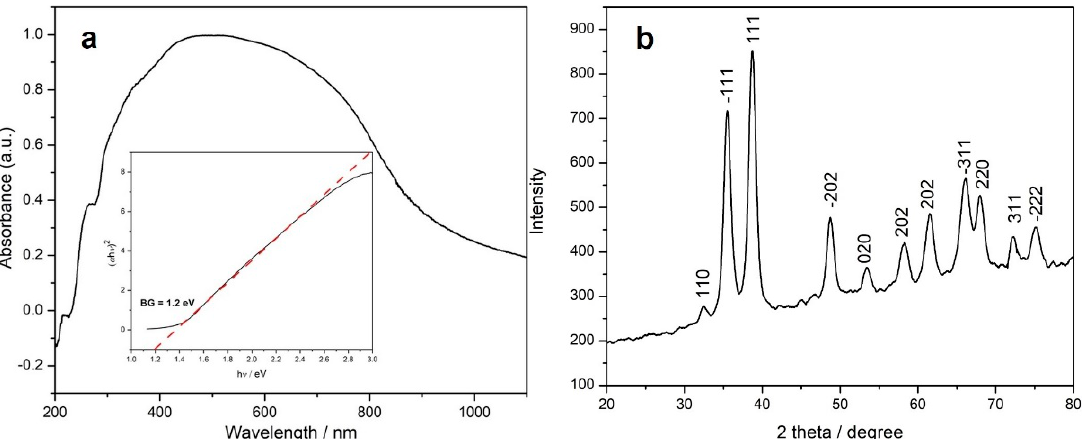
Figure 2. UV–vis spectrum ( a ) and X-ray powder diffractogram ( b ) of the CuONP sample (inset Figure 1a: Tauc plot for the estimation of the energy band gap of the CuONP oxide).